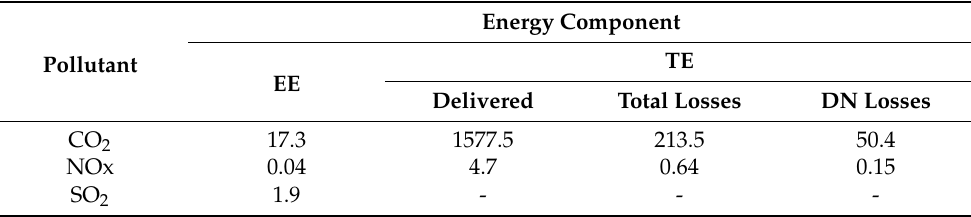
Table 17. Estimation of pollutant emissions developed for the consumed energy [forecast 2020 – optimized CEB—Hypothesis